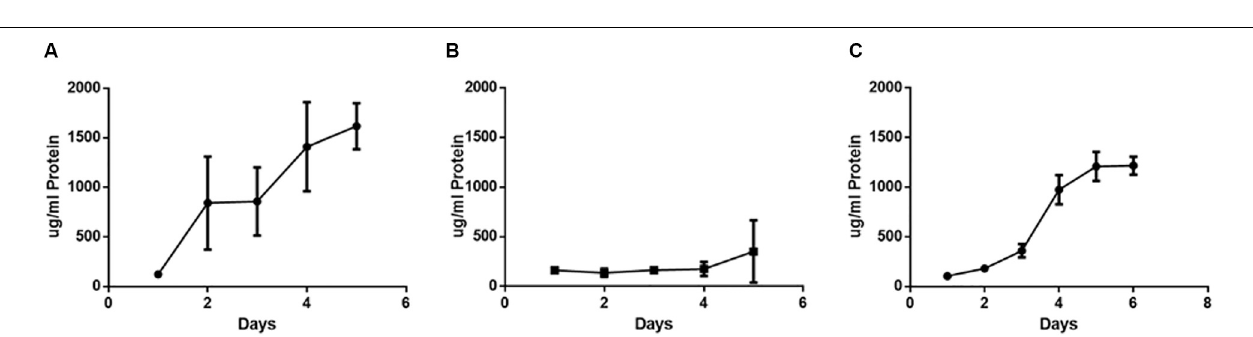
FIGURE 4 | Changes in carbohydrate content during polymicrobial biofilm growth. (A) Single species H. somni biofilm grown for 5 days. (B) Single species P. multocida strain C0513-P5 biofilm grown for 5 days. (C) Polymicrobial biofilm of H. somni grown for 3 days, P. multocida added, and growth continued for an additional 3 days. The carbohydrate content of the biofilm was measured by Anthrone assay. All experiments were performed in triplicate in three different experiments (9 datum points total).